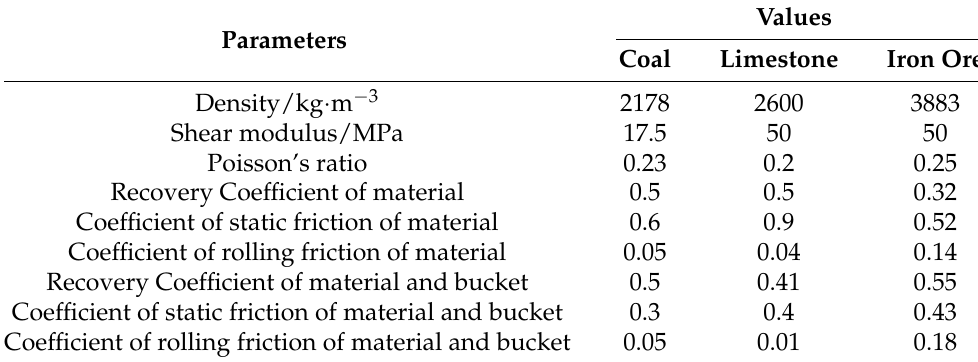
Figure 8. Working principle of hydraulic system. ( a ) Schematic diagram of the hydraulic system. ( b ) Working device structure. Table 5. Material